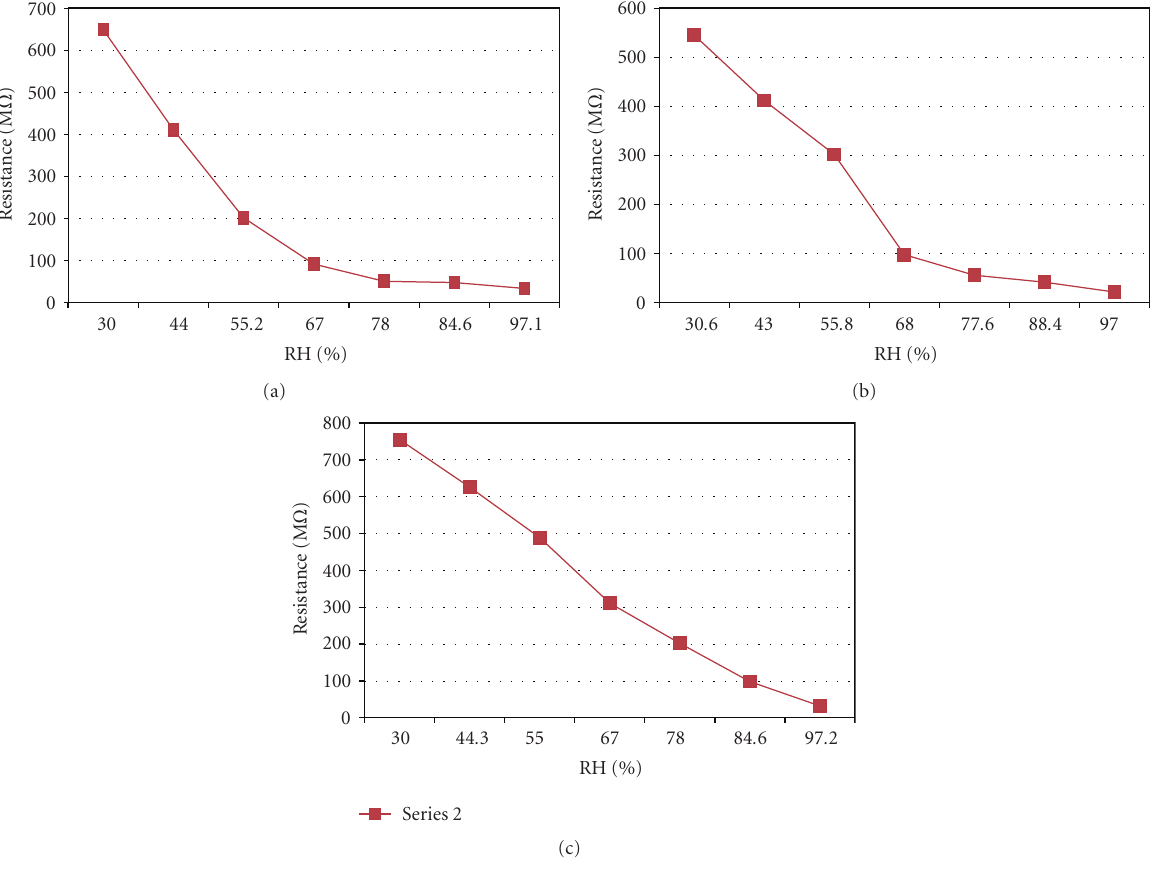
Figure 5: (a) TiO 2 , (b) SnO 2 , and (c) Ti 0 . 80 Sn 0 . 20 O 2